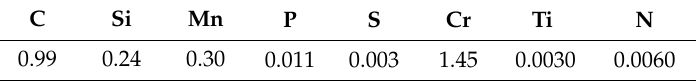
Table 1. The chemical composition of GCr15 bearing steel (wt %).